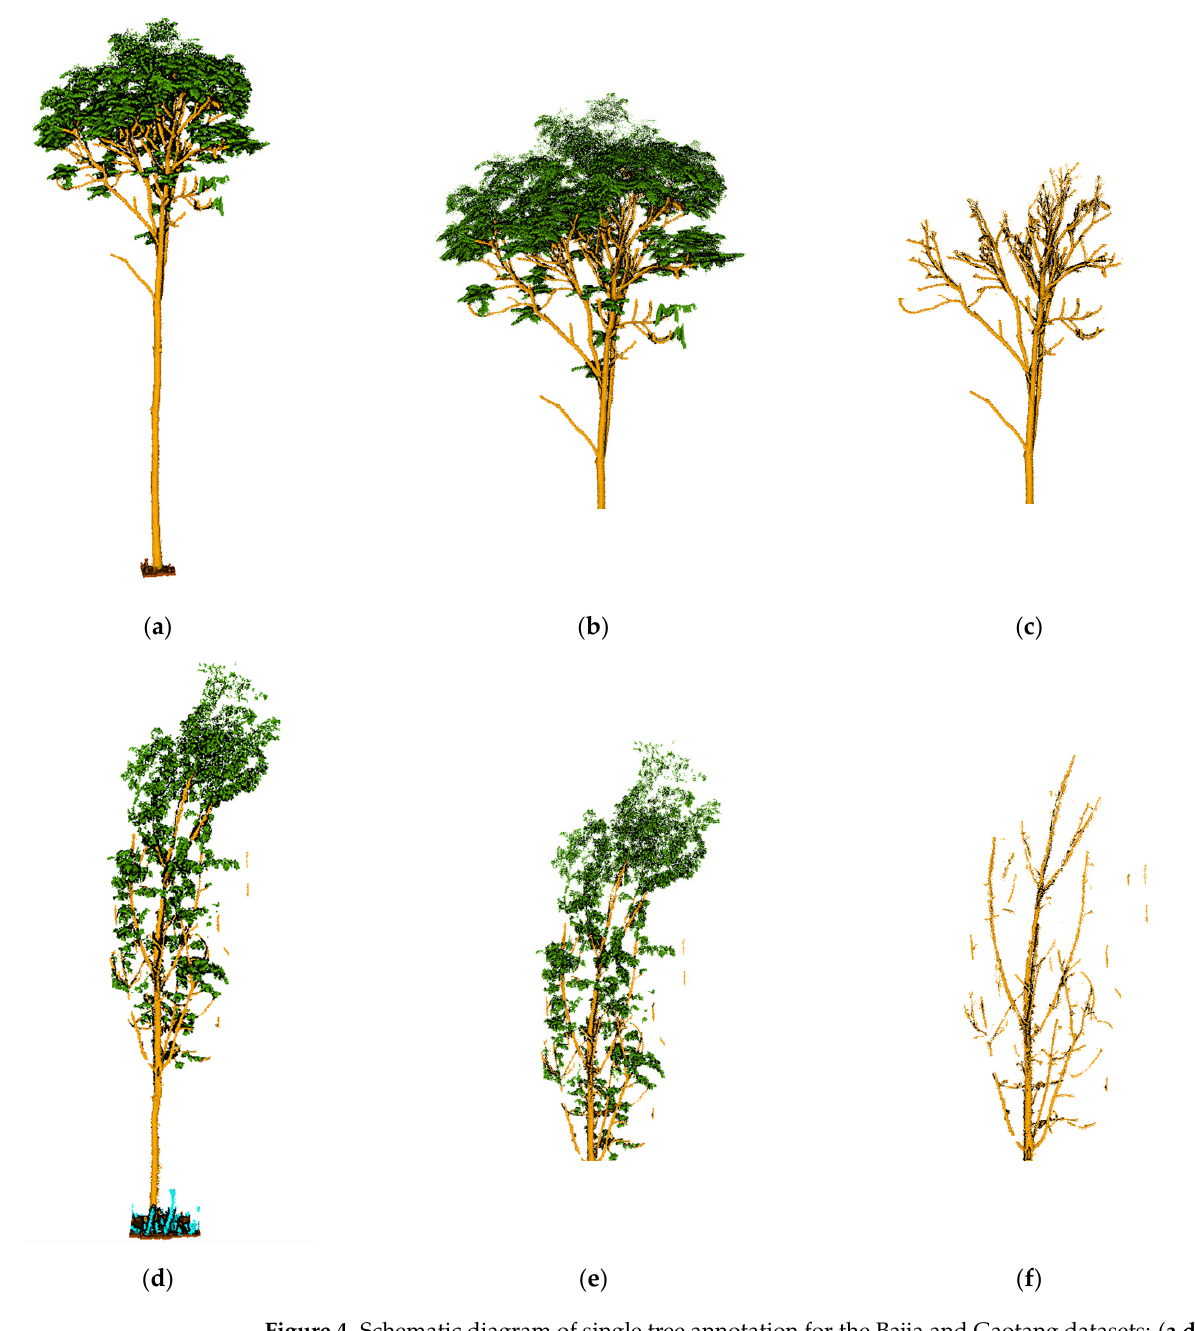
Figure 4. Schematic diagram of single tree annotation for the Bajia and Gaotang datasets: ( a , d ) The whole tree after labeling; ( b , e ) Labeling details of the foliage and stem of a single tree; ( c , f ) Clear stem of a single tree after labeling.